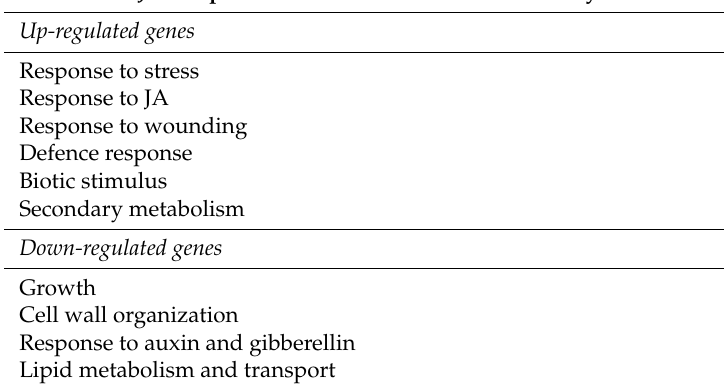
Table 2. Over-represented GO categories (biological function ontology) in the subset of JA-responsive genes in control plants only.